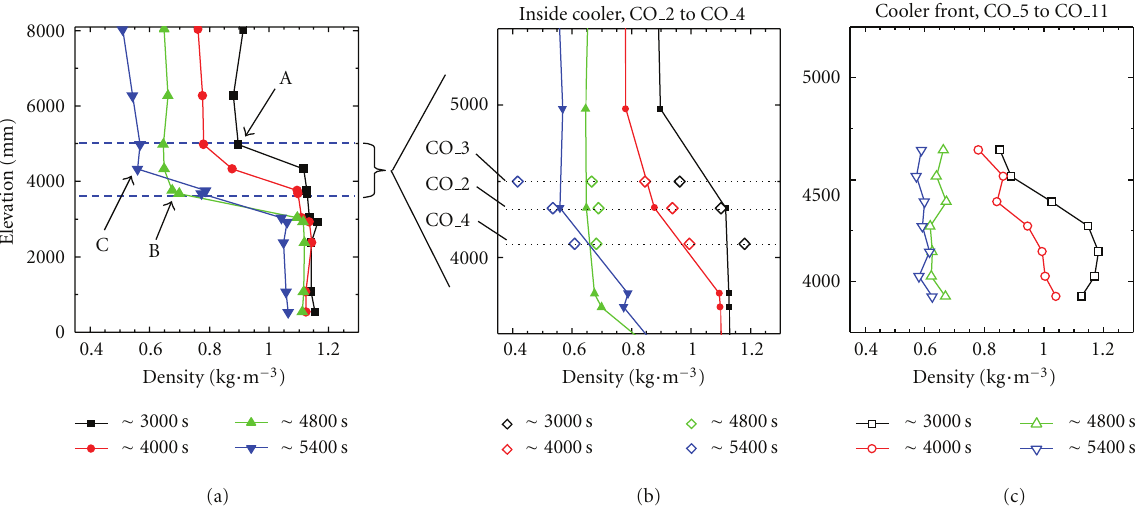
Figure 11: Density profile in Vessel 1 recorded for ST4 2 (a), inside (b) and in front of the cooler (c) with the time as parameter.